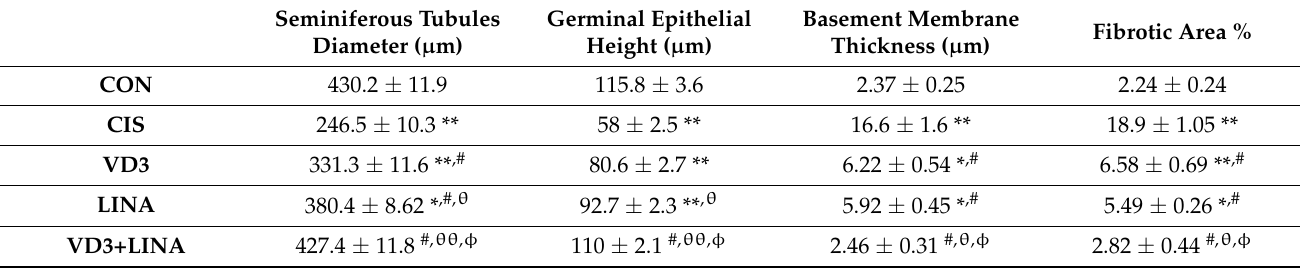
Table 2. Effect of vitamin D3 and/or linagliptin on morphometric parameters of seminiferous tubules in cisplatin-treated rats.